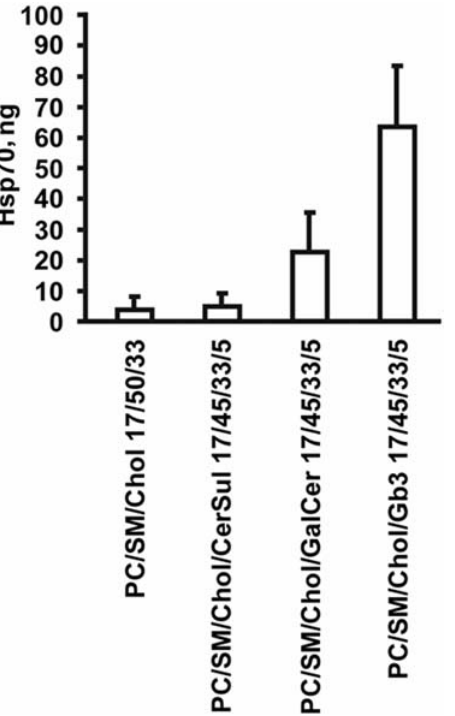
Figure 6. Hsp70 predominantly interacts with artificial raft liposomes containing Gb3. Quantification of the amount of recombinant Hsp70 protein associated with unilamellar raft-like liposomal pellet fraction consisting of 1-palmitoyl-2-oleoyl-sn-glycero- 3-phosphocholine (PC)/brain sphingomyelin (SM)/cholesterol (Chol), ( PC/SM/Chol , 17/50/33); 1-palmitoyl-2-oleoyl-sn-glycero-3-phospho- choline (PC)/brain sphingomyelin (SM)/cholesterol (Chol)/brain cere- broside sulfatide (CerSul) ( PC/SM/Chol/CerSul , 17/45/33/5); 1-palmi- toyl-2-oleoyl-sn-glycero-3-phosphocholine (PC)/brain sphingomyelin (SM)/cholesterol (Chol)/galactocerebroside (GalCer) ( PC/SM/Chol/Gal- Cer , 17/45/33/5); and 1-palmitoyl-2-oleoyl-sn-glycero-3-phosphocho- line (PC)/brain sphingomyelin (SM)/cholesterol (Chol)/globotriasoylcer- amide (Gb3) ( PC/SM/Chol/Gb3 , 17/45/33/5). Data are the total amount of Hsp70 (ng) in the pellet fraction containing liposomes and are means ( 6 SE) of 3 to 5 independent experiments.